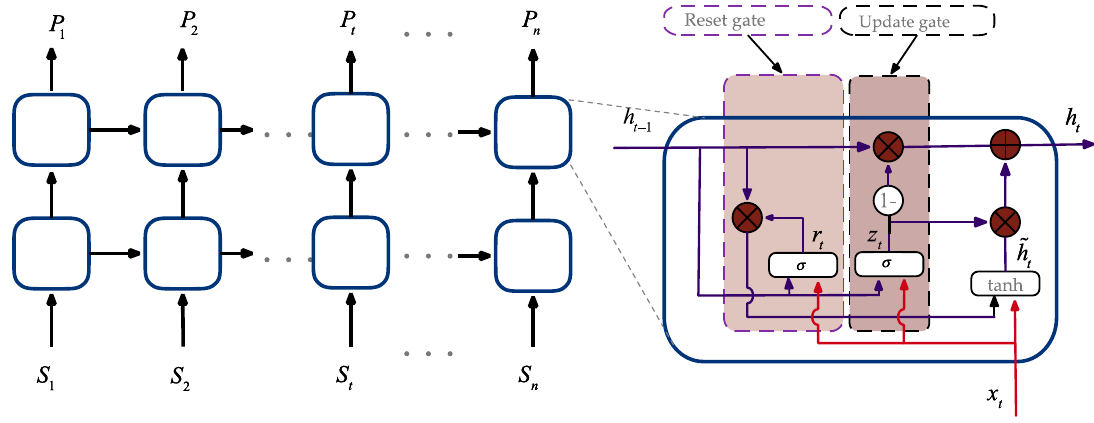
Figure 6. The network structure of the gated recurrent unit (GRU).